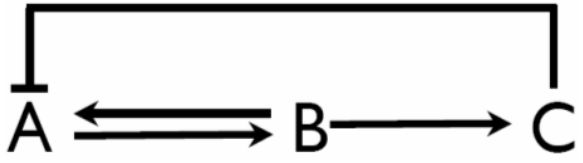
Figure 3: Simple Interaction Gene Regulatory Network : In the simple model, three interacting genes form a network in a cell. Here Gene A activates Gene B. Gene B activates Gene A and Gene C, and Gene C inactivates Gene A. Thus several levels of regulation are possible with the three interacting